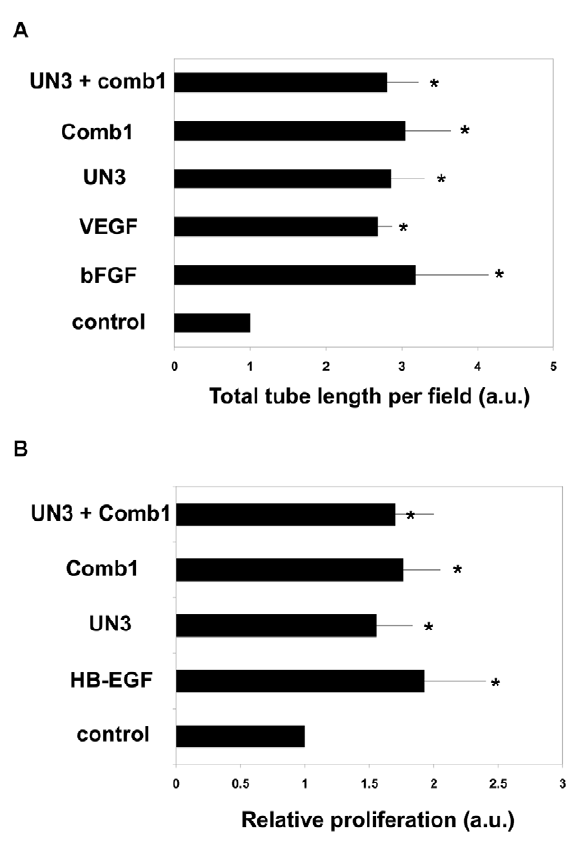
Figure 5. ECM-and platelet extract-derived peptides stimulate in vitro angiogenesis and epithelial proliferation. A – In vitro angiogenesis assay. Bovine capillary endothelial cells were plated on the surface of growth factor reduced Matrigel in the presence or absence of 100 nM comb1 or 250 nM UN3, or the two peptides combined. DMEM supplemented with 1% BCS was used as control, cells that have received DMEM/1% supplemented with 10 ng/ml bFGF or VEGF served as positive control. Total tube length was measured at 7 h post-plating. Relative tube length compared to control is shown. B – In vitro epithelial proliferation assay. Hacat cells were plated as described in Materials and Methods. The peptides were added at 100 or 250 nM (comb1 and UN3 respectively). Cell counting was performed at 5 days post-plating. Relative cells numbers as compared to control are shown. Data are presented as mean + / 2 standard error; * - indicates p ,